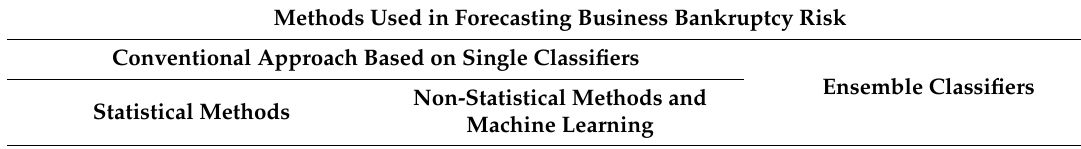
Table 1. List of methods applied in forecasting business bankruptcy